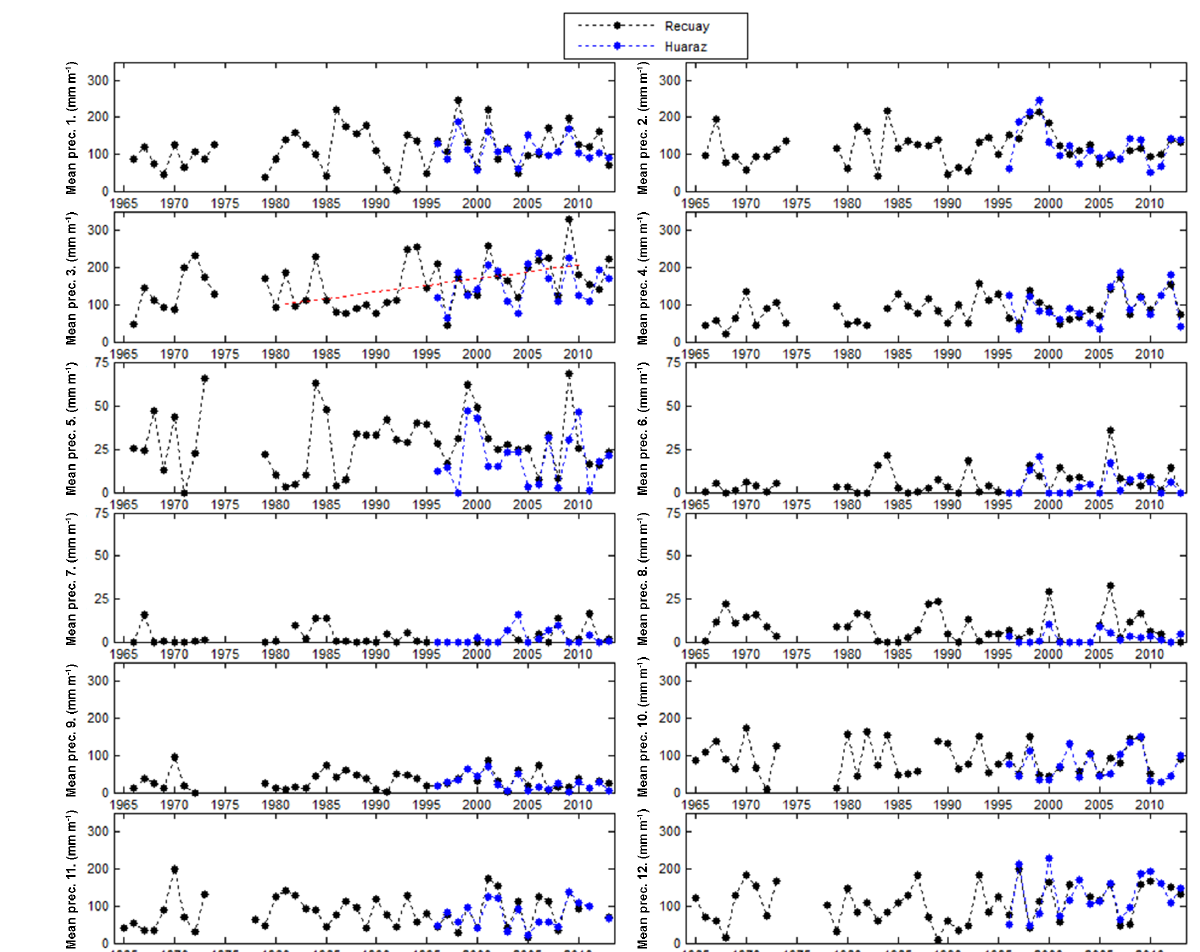
Figure A3. Monthly precipitation totals from the Recuay and Huaraz time series. The number in the y label corresponds to the month. Be aware of the different y axis for months 5–8 (May to August). Red dashed line shows significant trend for the period